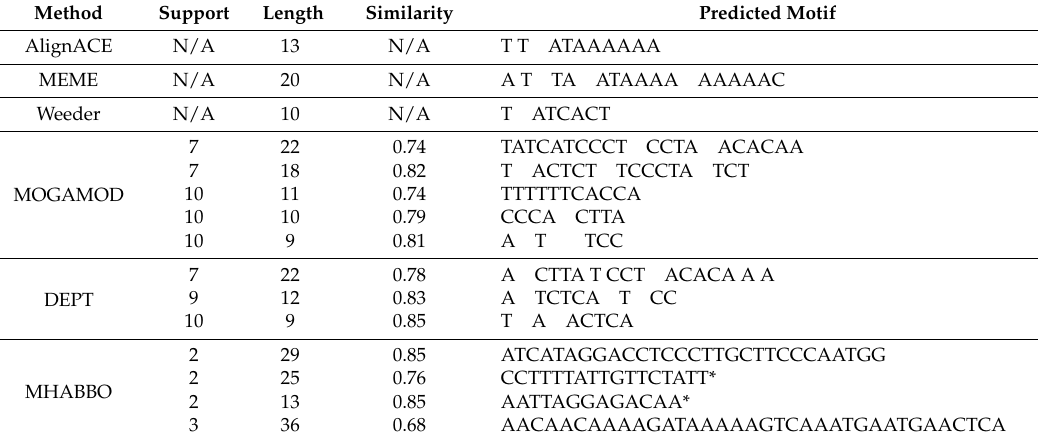
Table 7. Comparisons of the predicted motif with different methods for